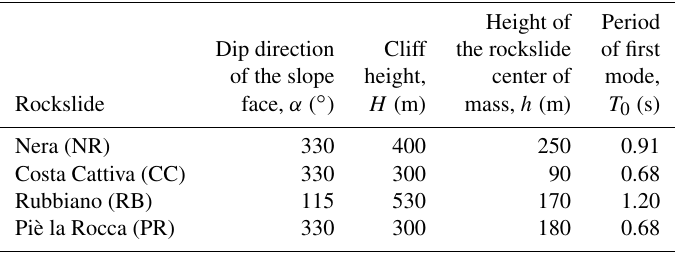
Table 5. Parameters utilized to calculate the topographic modification of the seismic motion at the rockslide sites. Height of Period Dip direction Cliff the rockslide of first of the slope height, center of